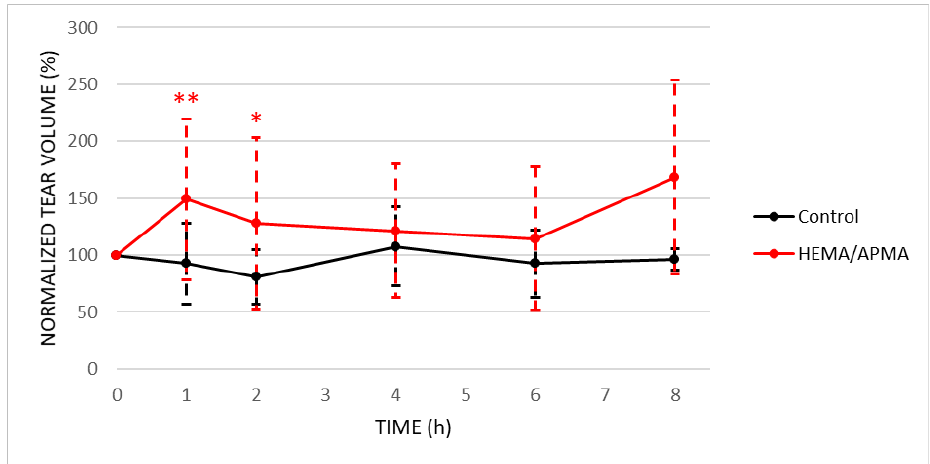
Figure 8 shows the normalized effect of the melatonin-eluting HEMA/APMA contact lenses on the tear volume, and Table 1 summarizes the raw values of this tear volume and the intraocular pressure.